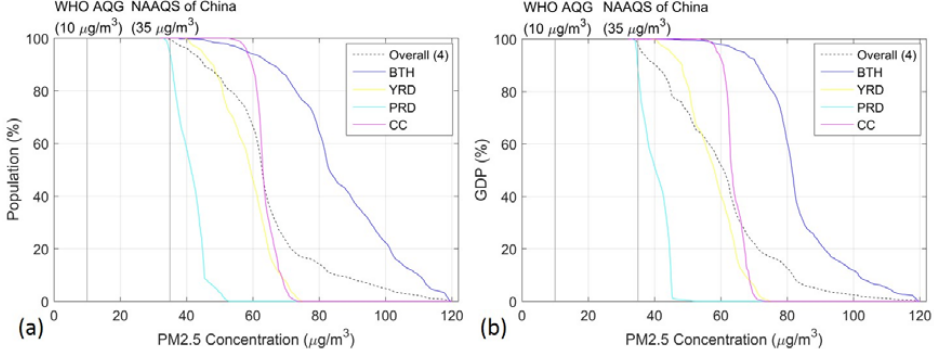
Figure 4. Cumulative percent distribution by annual average PM 2.5 concentrations which is estimated from station-based monitoring data in 2014 ( a ) Cumulative percent distribution of population; ( b ) Cumulative percent distribution of GDP. The dashed line represents the computing on the overall four urban